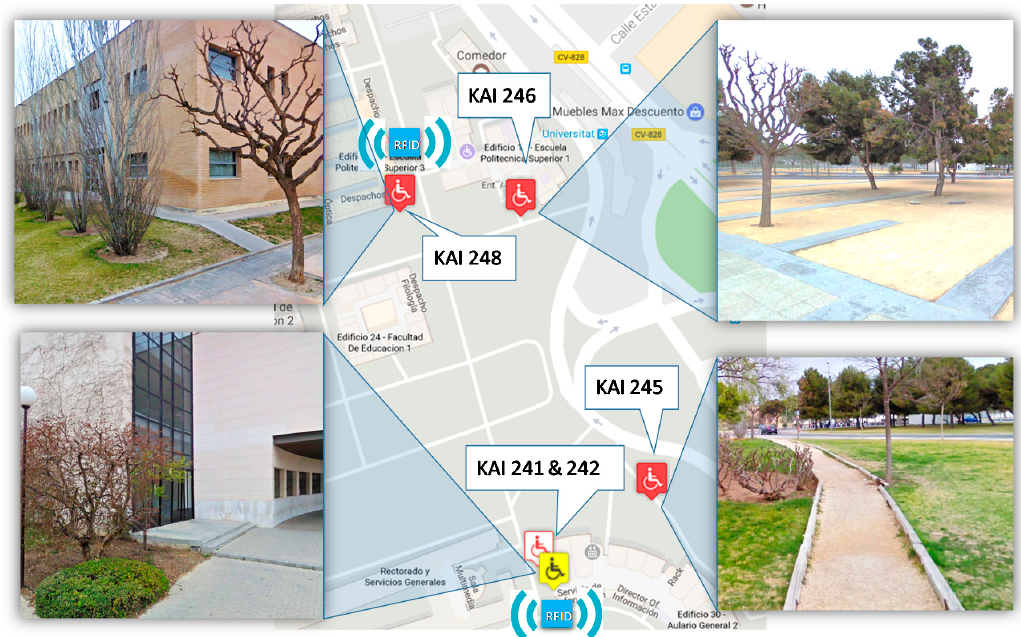
Figure 16. Outdoor scenario and RFID-based acquisition components deployed. Table 4. Different KAIs obtained in the validation process along some common paths. Test 2. Common Path among Some Buildings of the Campus